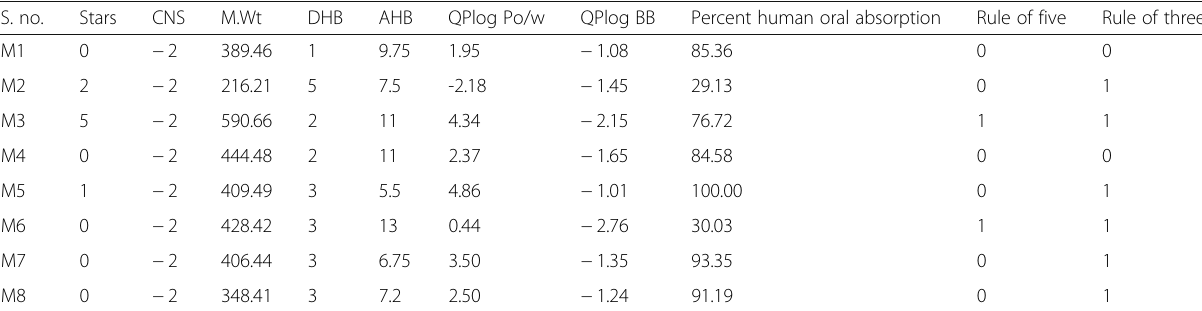
Table 6 ADME properties of the top docked molecules S. no.